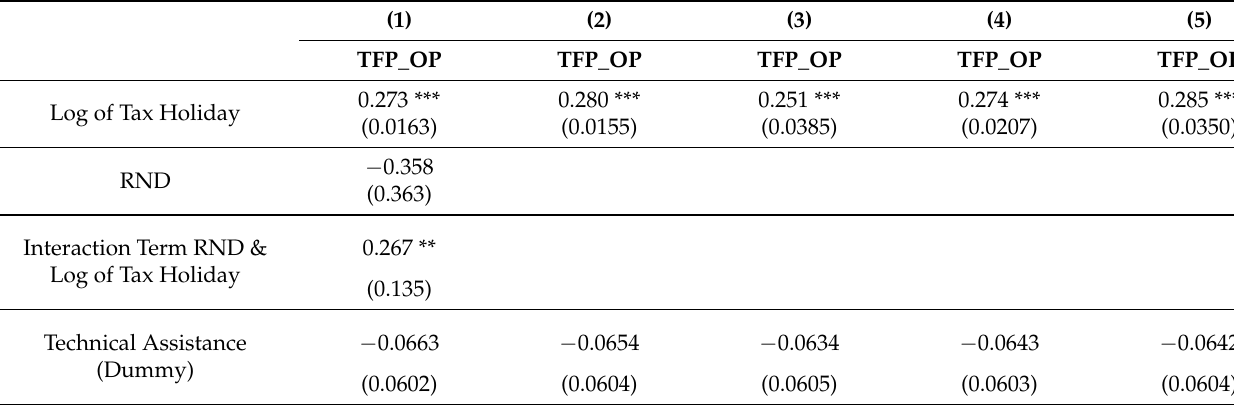
Table 11. Mechanism Testing with Five Technological